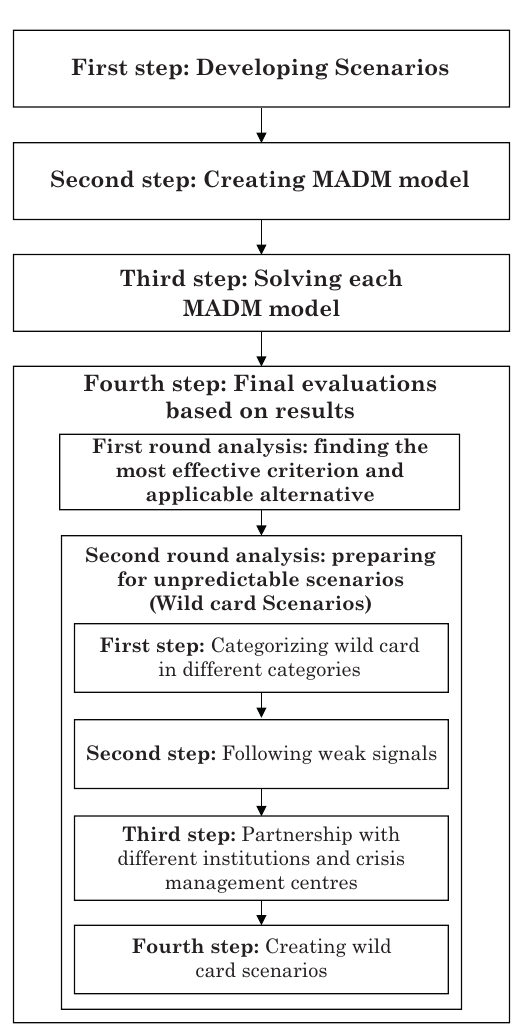
fig. 1. The process of maDm-based